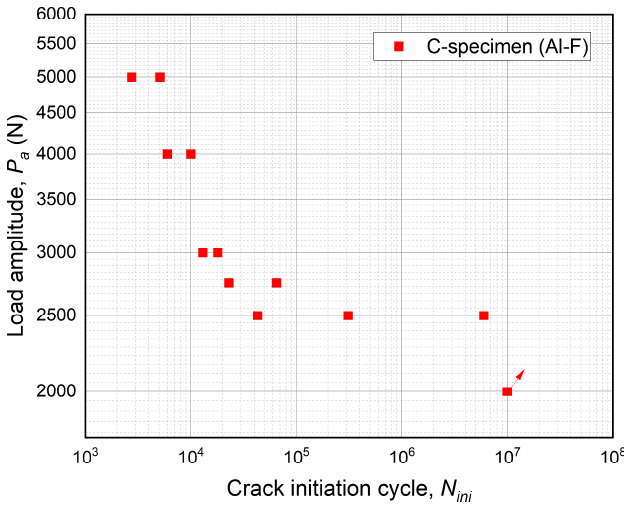
Figure 10. Load–cycle curve of the C-specimens with the Al-F material.